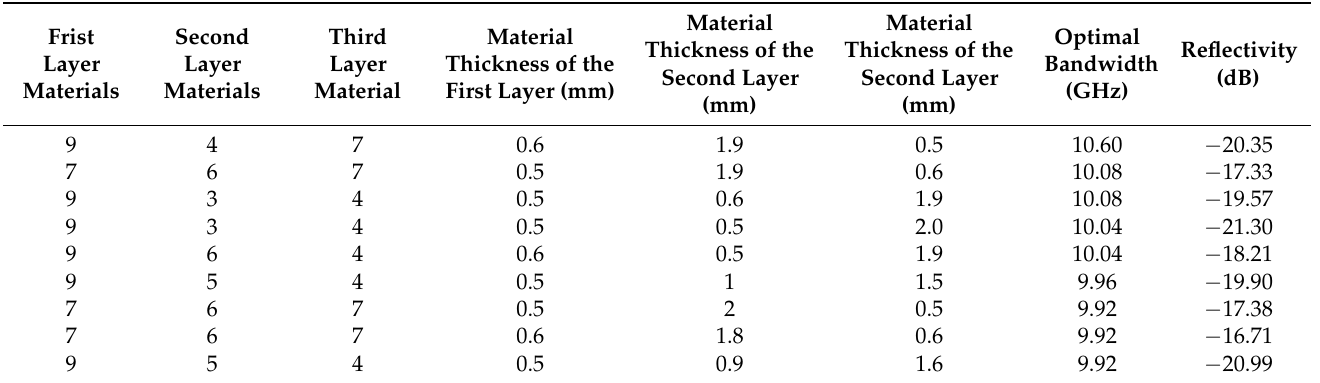
Table 4. The optimization results using objective function F1 (three-layers) of GA algorithm.